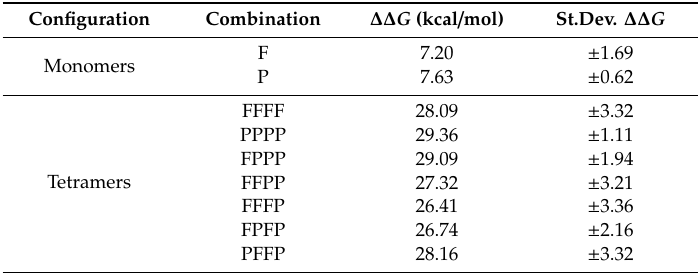
Table 1. FoldX analysis of amino acid changes on tetramer stability.